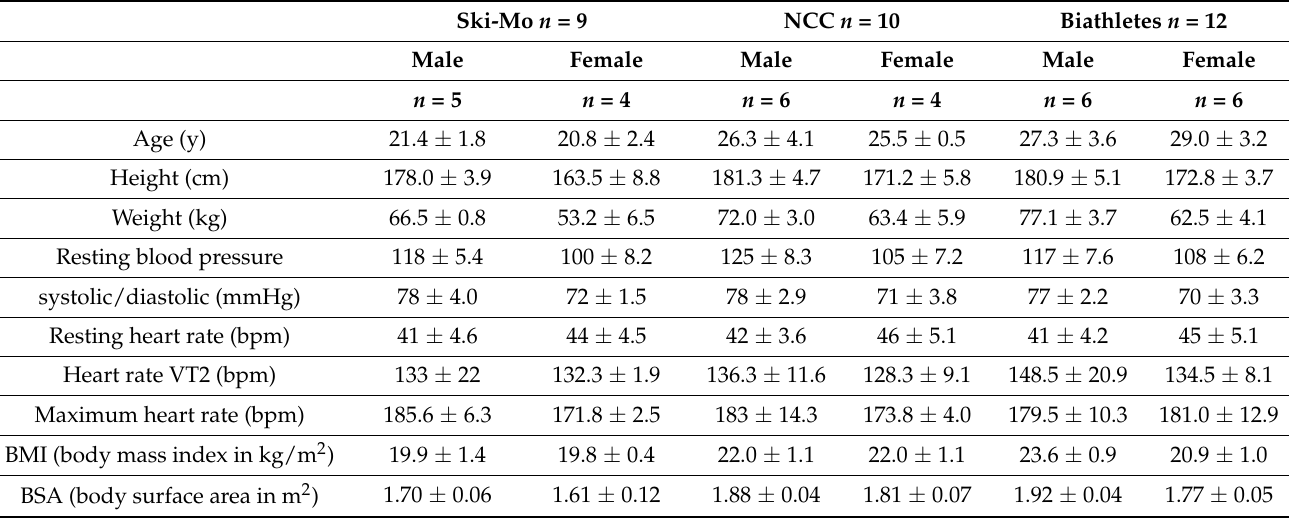
Table 2. Baseline winter sport professional